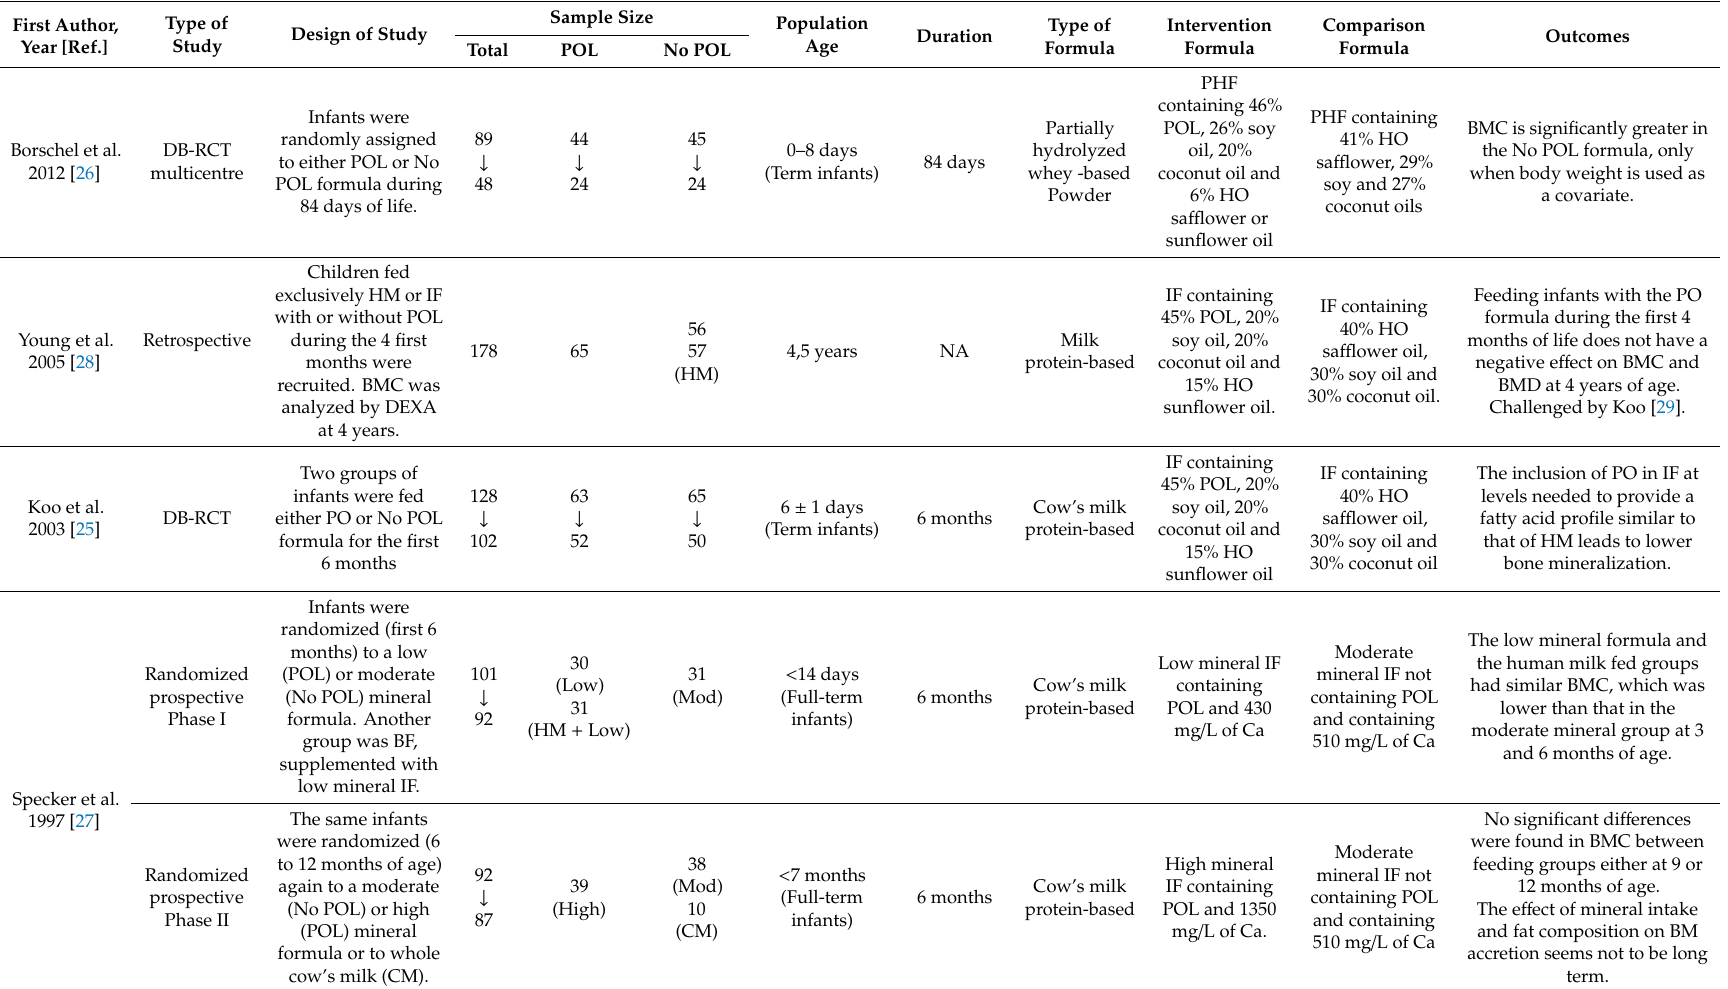
Table 3. Characteristics of studies describing bone mineralization e ff